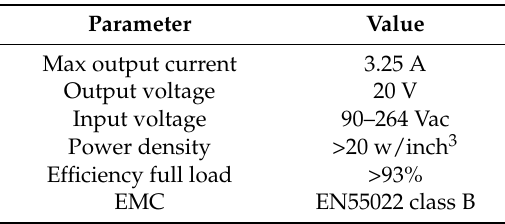
Table 1. Converter target specifications.